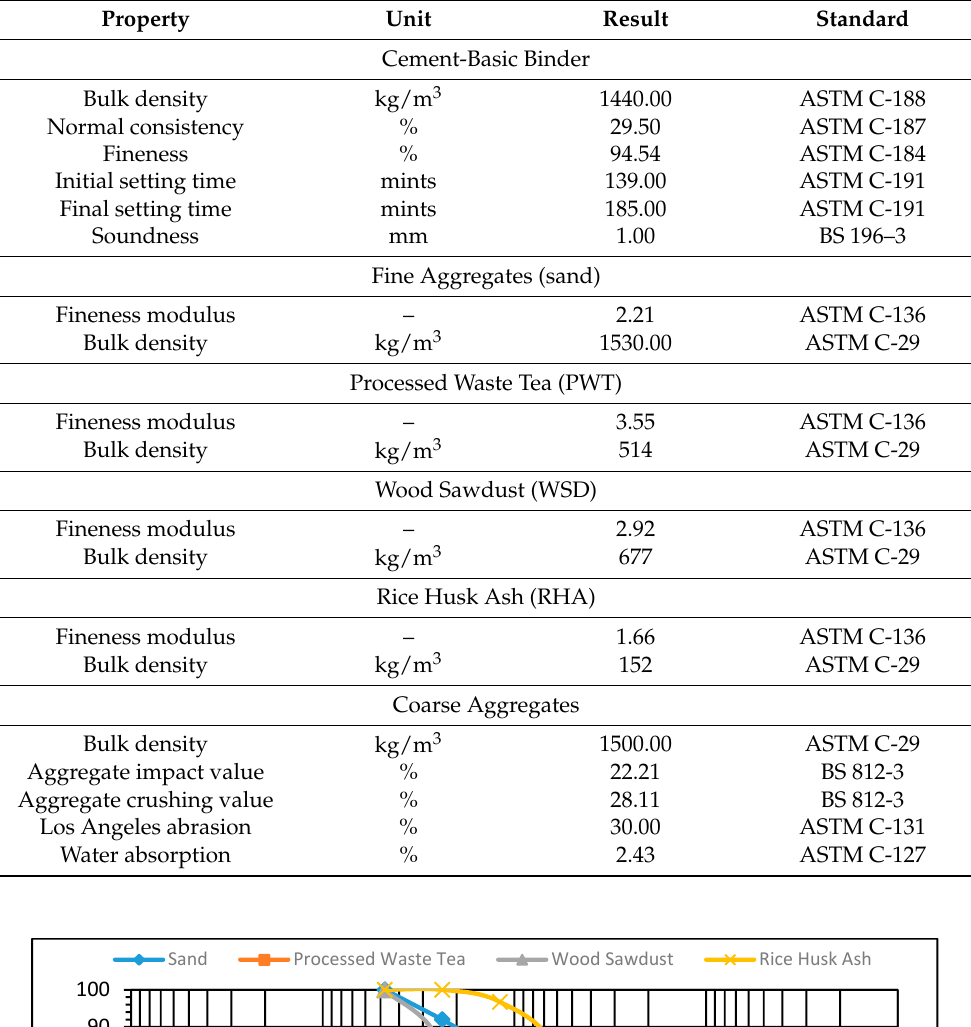
Table 2. Basic and waste materials physical properties.